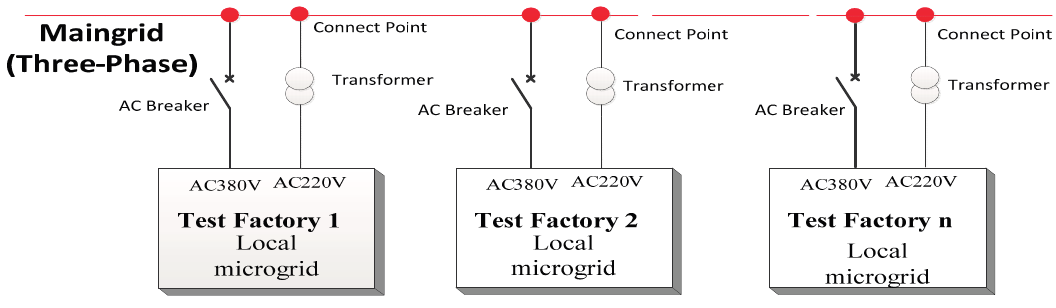
Figure 2. The hybrid AC–DC micro-grid layout based on